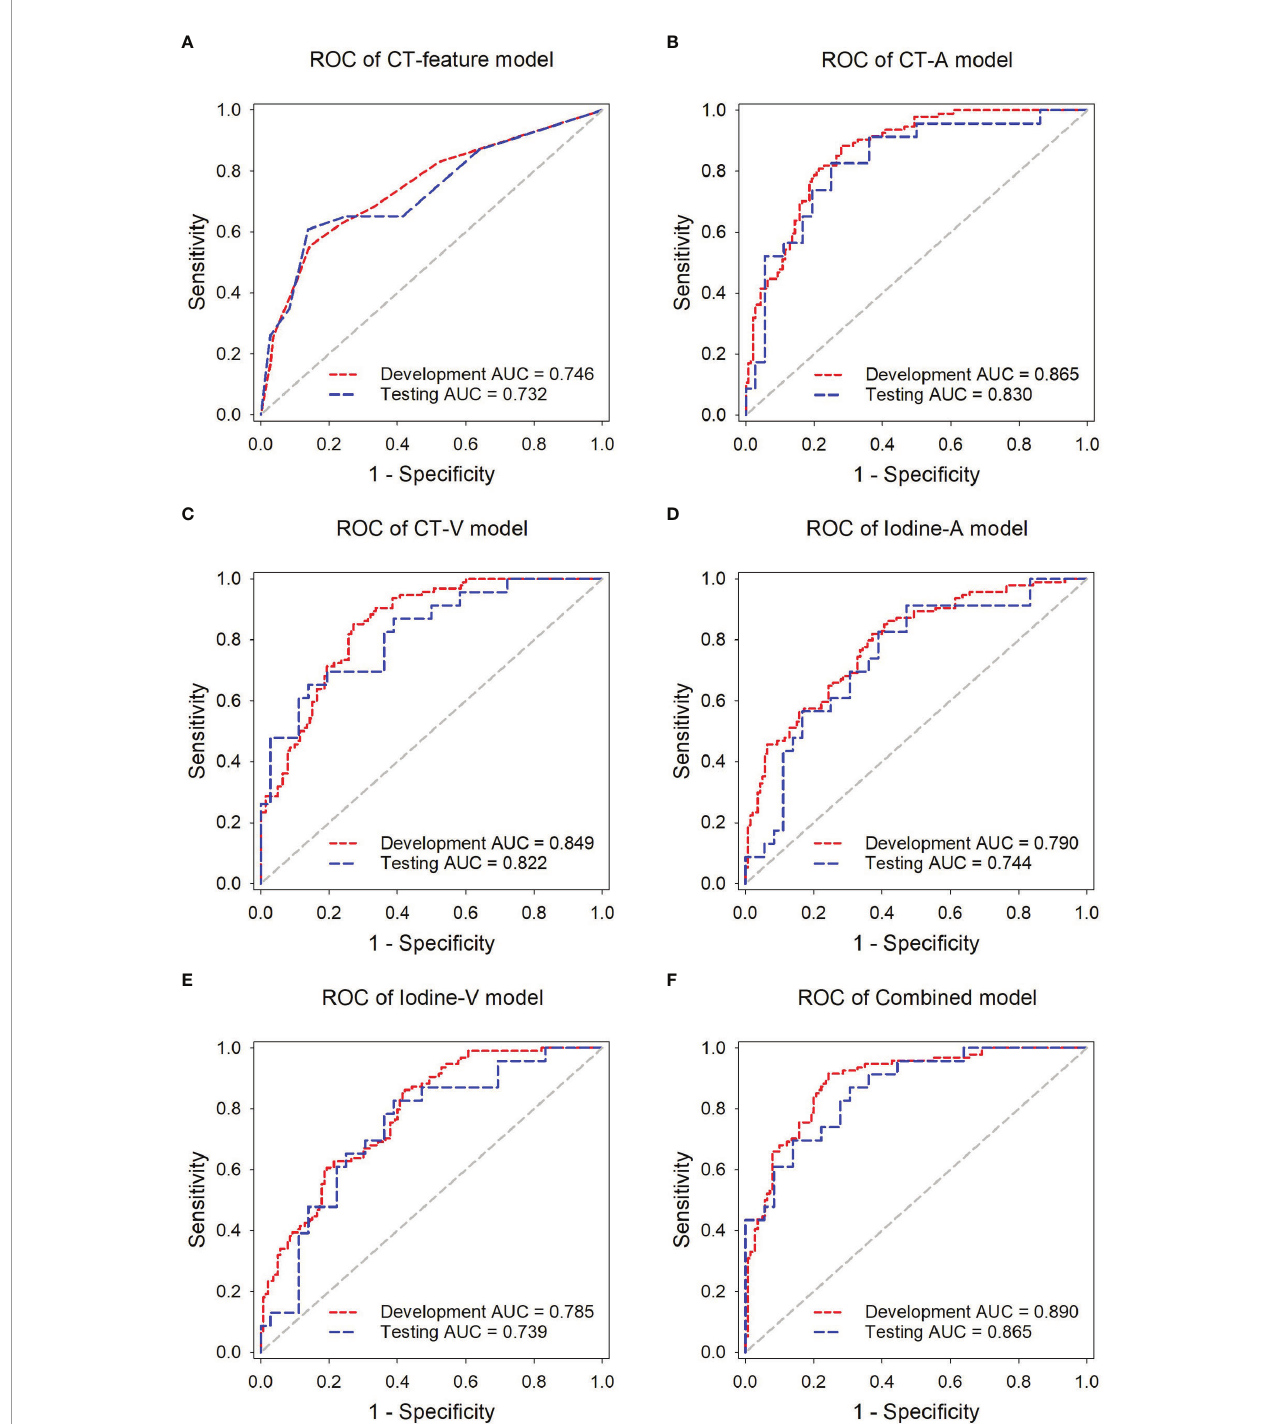
FIGURE 4 | ROC analysis of the predictive models in the development and independent testing sets. ROC curves of the (A) CT-feature model, (B) CT-A model, (C) CT-V model, (D) Iodine-A model (E) Iodine-V model, and (F) Combined model in the delelopment and testing sets,